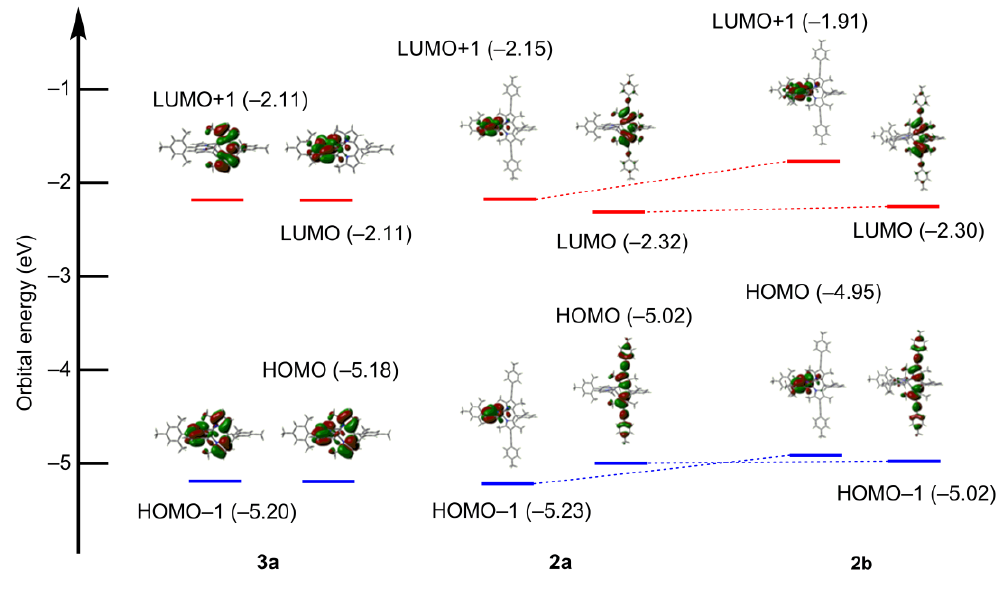
Cl solvation using the PCM 2 2